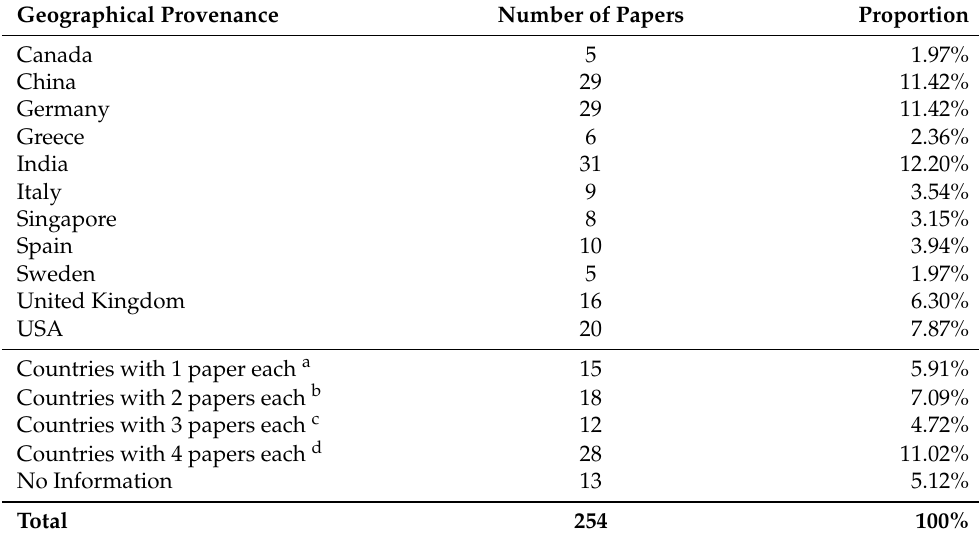
Table 3. Geographical distribution of included papers.